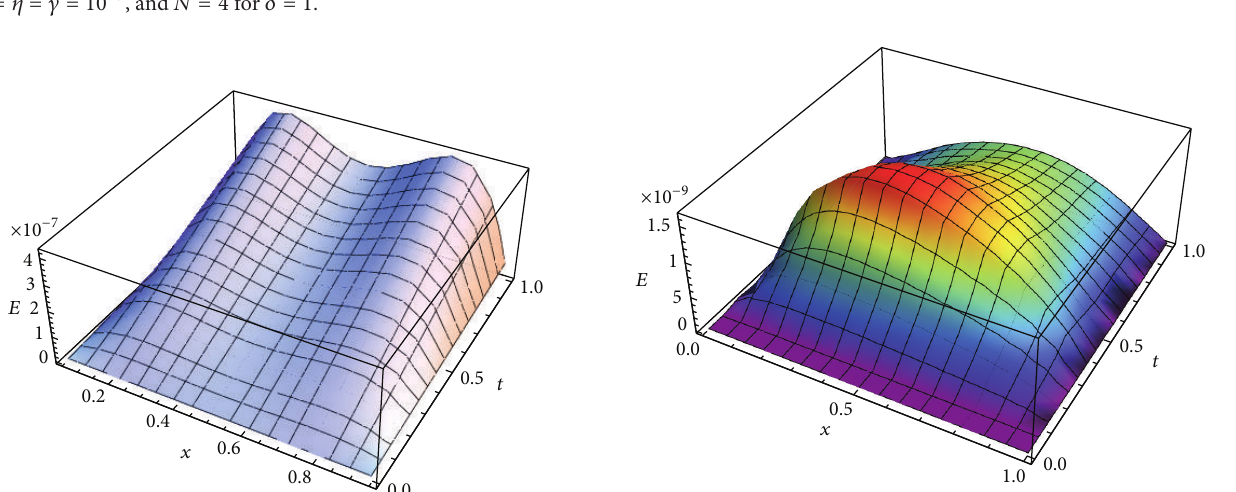
Figure 1: The absolute error of problem (35) where 𝛼 = 𝛽 = 0 , ] = 𝜂 = 𝛾 = 10 −3 , and 𝑁 = 4 for 𝛿 = 1 .